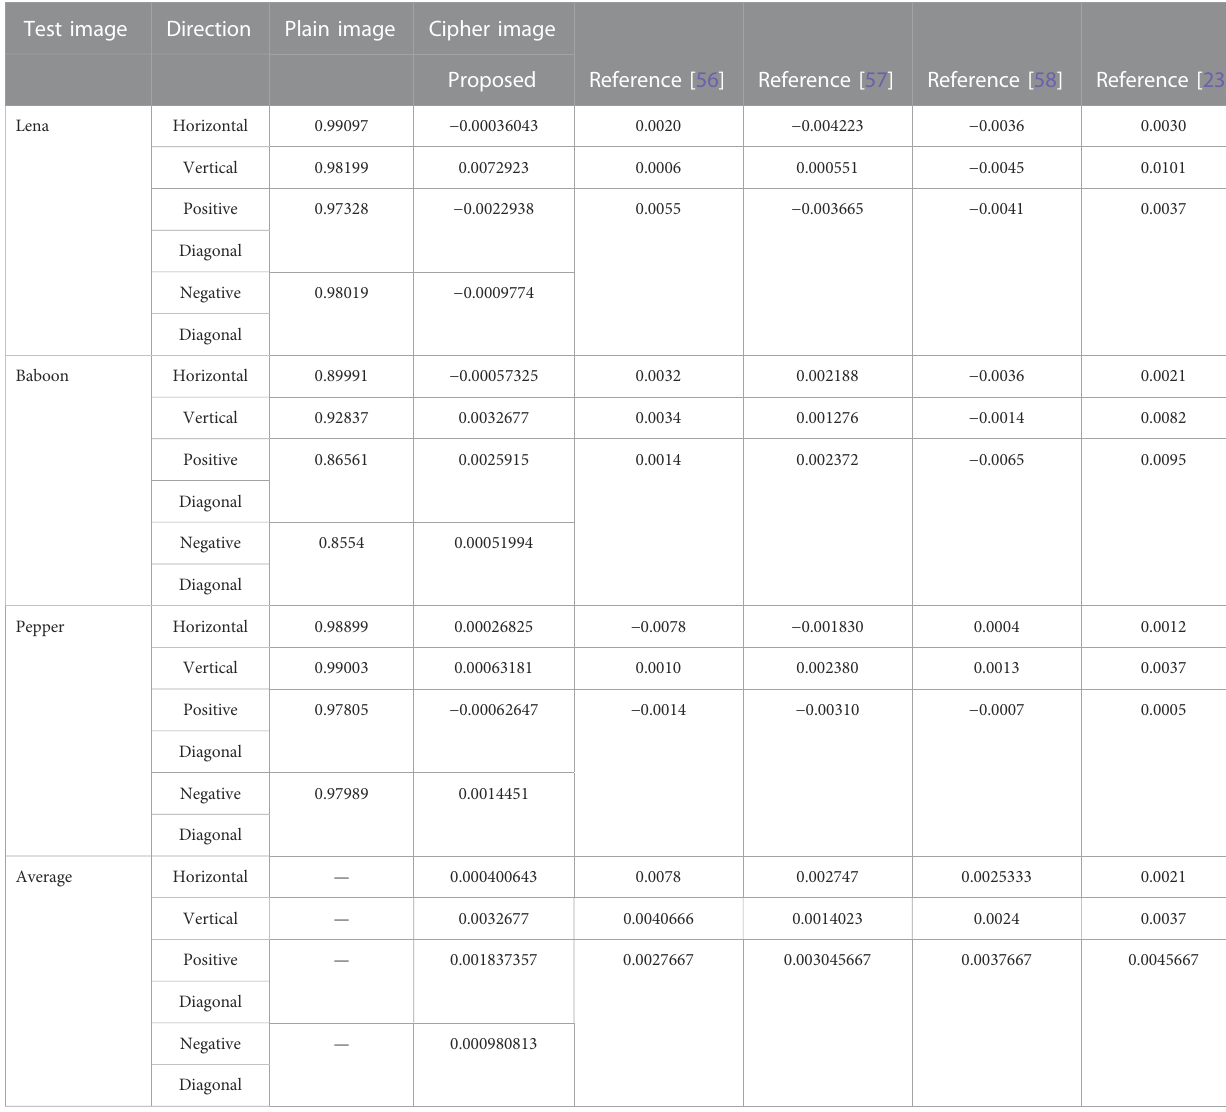
TABLE 1 Correlation coef fi cient of the plain image and Cipher image.